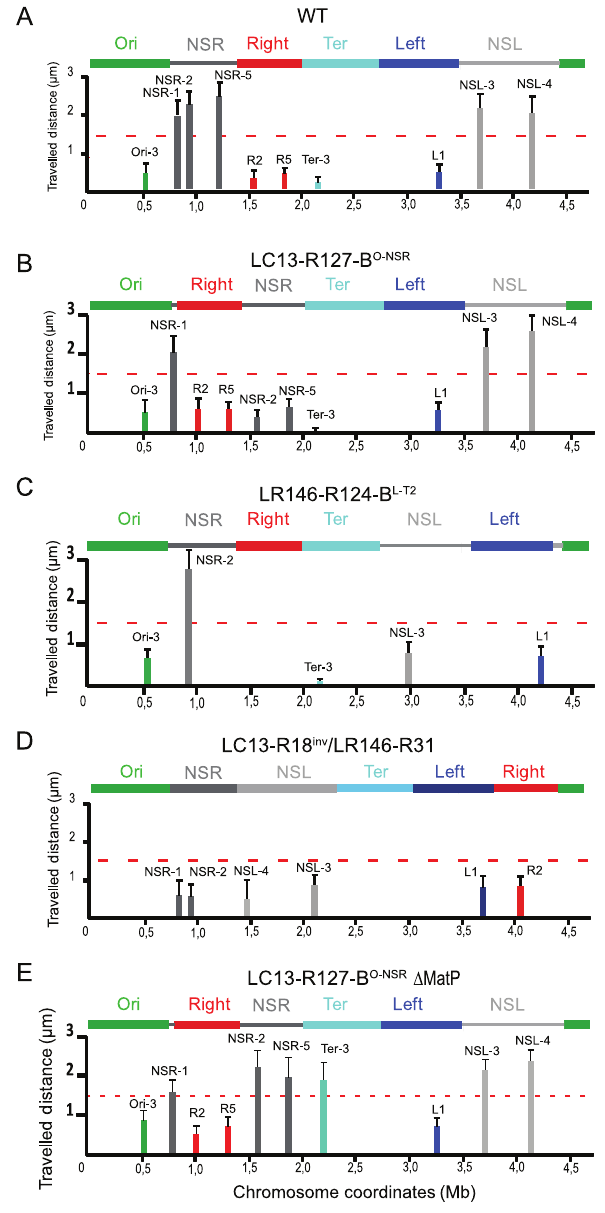
Figure 2. Travelled distance of different markers in strains with a wt or rearranged configurations. The mean value and the standard deviation calculated for 30 independent foci are indicated by columns. The x axis represents the chromosome genetic map; the positions of the loci are in Mb from oriC . The MDs and NS regions are indicated above the graph. (A) wt strain (markers Ori-3, NSR-1, NSR-2, NSR-5, Right-2 (R2), Right-5 (R5), Ter-3, Left-1 (L1), NSL-3 and NSL-4 are indicated from left to right). (B) Strain LC13-R127-B O-NSR with a transposition of the Right MD between the Ori MD and the NS Right region (markers Ori-3, NSR-1, Right-2 (R2), Right-5 (R5), NSR-2, NSR-5, Ter-3, Left-1 (L1), NSL-3, and NSL-4 are indicated from left to right). (C) Strain LR146-R124-B L-T2 with the NS Left region transposed between the Ter and left MDs (markers Ori-3, NSR-2, Ter-3, NSL-3, and Left-1(L1) are indicated from left to right). (D) strain LC13-R18 inv /LR146-R31 with the two NS regions located on the right replication arm (markers NSR-1, NSR-2, NSL-3, NSL-4, Left-1, Right-2) (E) strain LC13-R127-B O-NSR D matP with a transposition of the Right MD between the Ori MD and the NS Right region with a deletion of matP (markers Ori-3, NSR-1, Right-2 (R2), Right-5 (R5), NSR-2, NSR-5, Ter-3, Left-1 (L1), NSL-3 and NSL-4 are indicated from left to